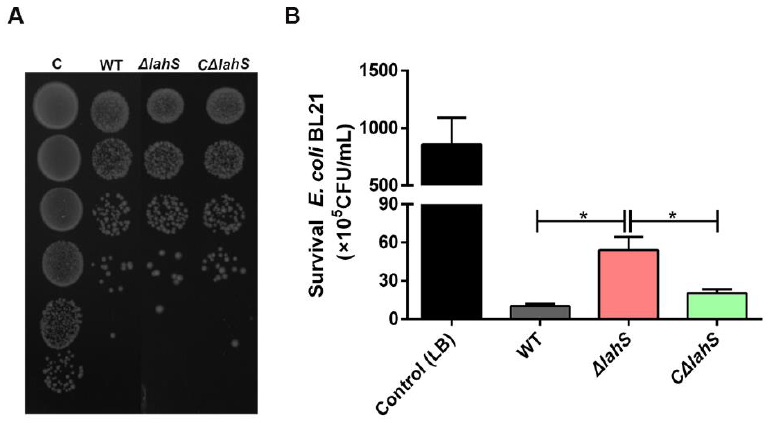
Figure 6. Competition ability of the wild-type and lahS mutant strains. ( A ) The image of competition ability is shown on Luria Bertani broth (LB) agar plate. ( B ) Quantification analysis of competition ability of the wild-type and lahS mutant strains. The respective bacterial strains were cultured together at a ratio of 1:1. The competition capability of A. hydrophila strains against E. coli BL21 was defined as the amount of observed E. coli survival after antagonism. Data are presented as the means ± SEM of three independent experiments. * p < 0.05.